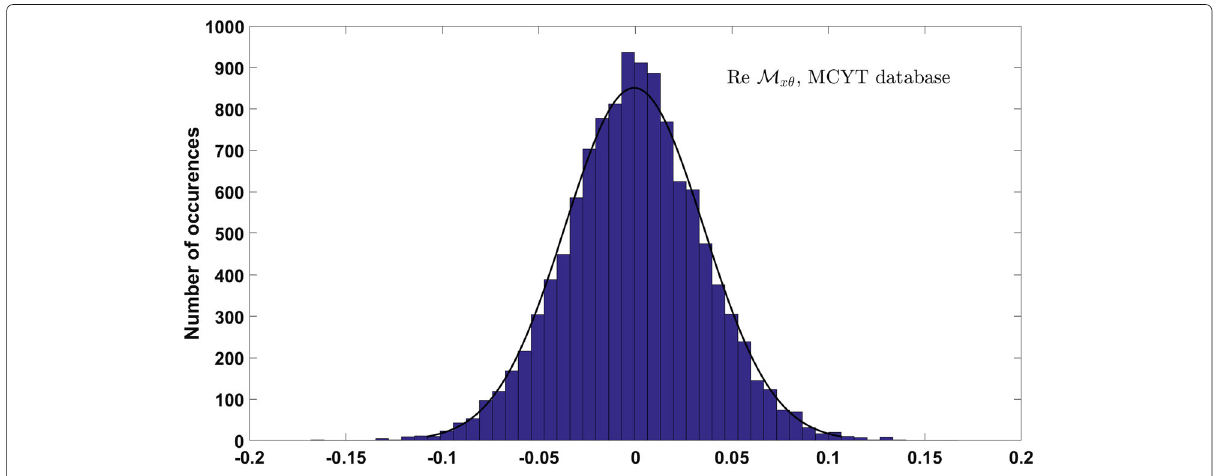
Fig. 4 Histogram of Re M x θ , and a fitted Gaussian